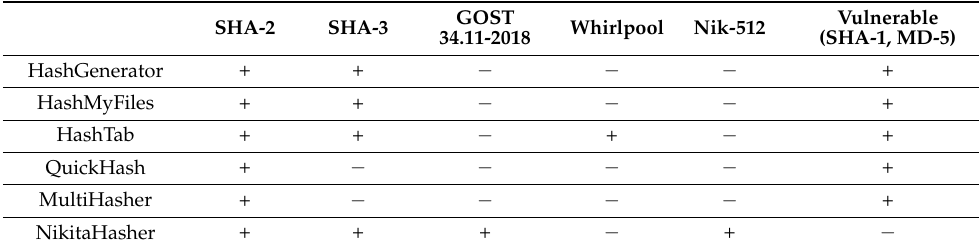
Table 2. Comparison of hashing programs.